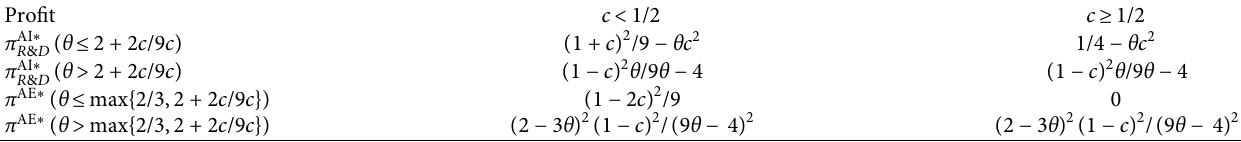
Table 1: Profits of firms in situation